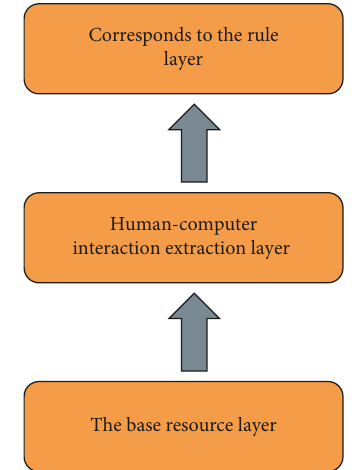
Figure 5: Three levels of lexical chunk database construction